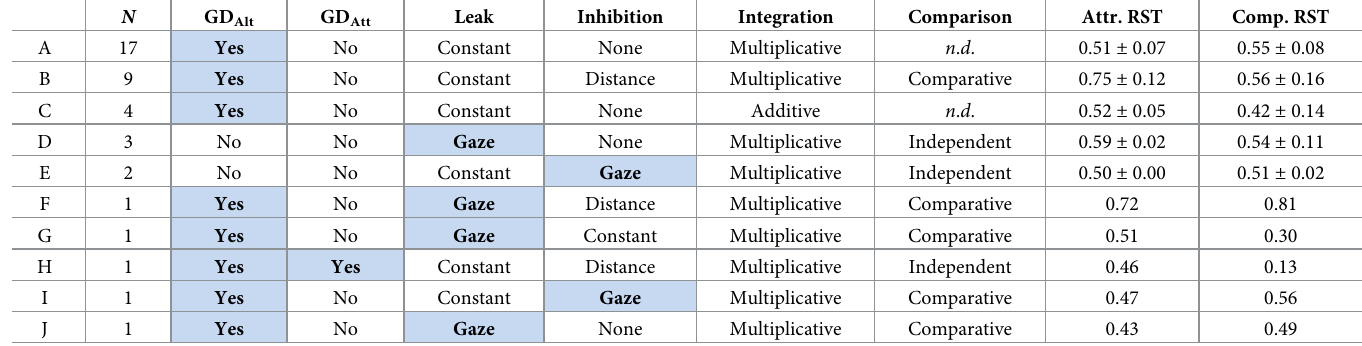
Table 2. Overview of individually best fitting model variants. N indicates the number of participants best described by the variant described in the row. The top variant (A) coincided with the GLA model. Note that all individually best fitting models had some form of gaze-dependence (blue shaded cells, mostly alternative-wise gaze-dis- count). "n . d . " denotes variants where comparison mechanisms were not distinguishable by the analysis. The last two columns show observed mean ( ± s.d. if applicable) RST of participants best described by each variant, for attraction and compromise trials, respectively. N GD